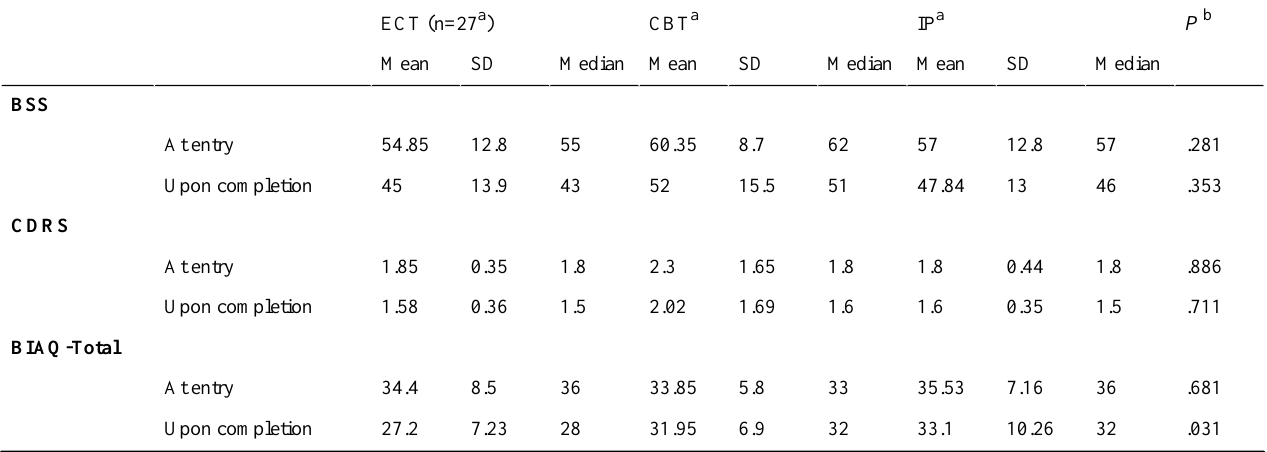
Table 3. Means, standard deviations, and medians for BSS, CDRS, and BIAQ-Total at entry to the study and upon completion of the inpatient